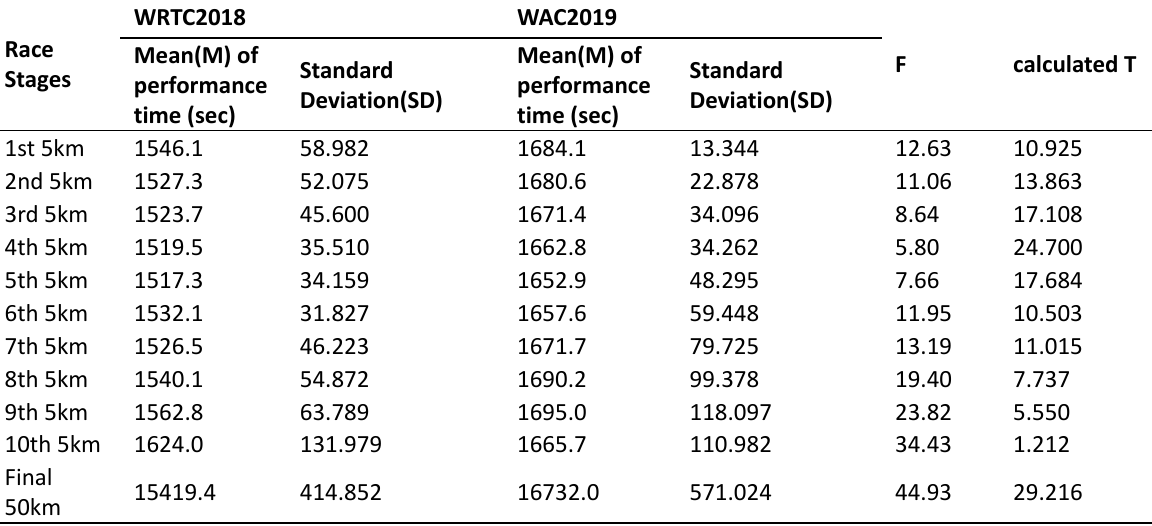
Table 11. T-test for performance time averages of each stage and final 50km between both